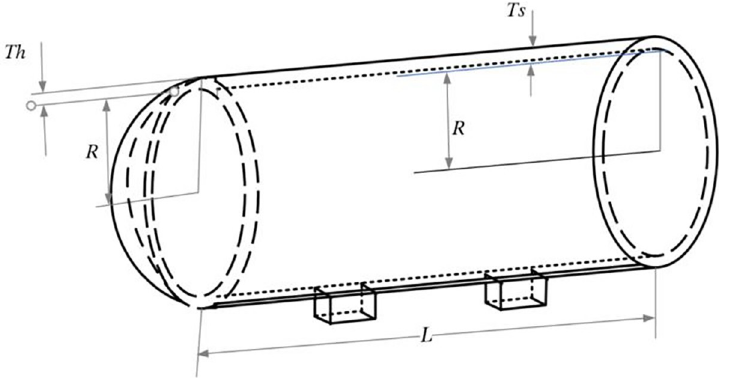
Fig 9. Pressure vessel.